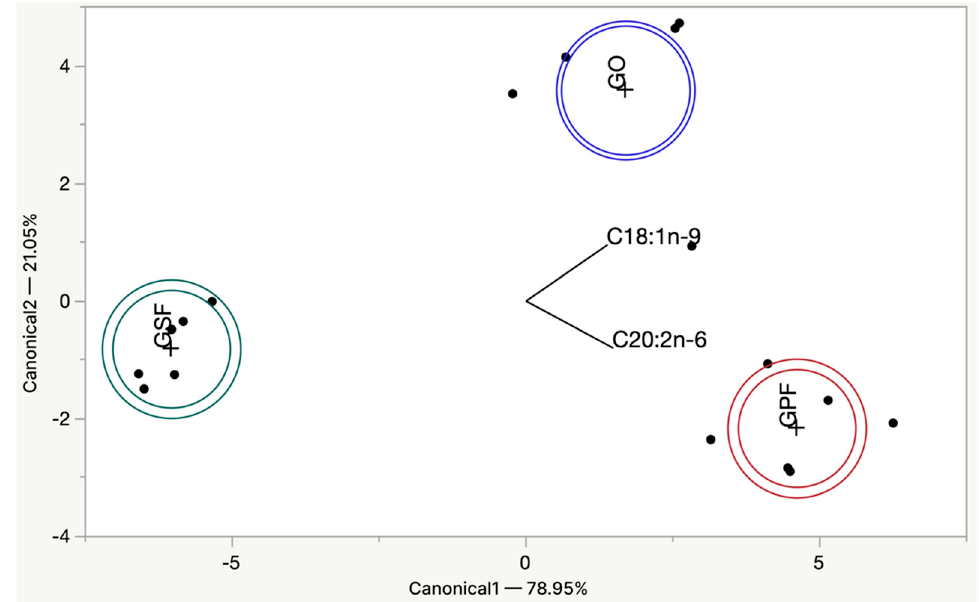
Figure 3. Scatter plot of the first two canonical variables of the three burger